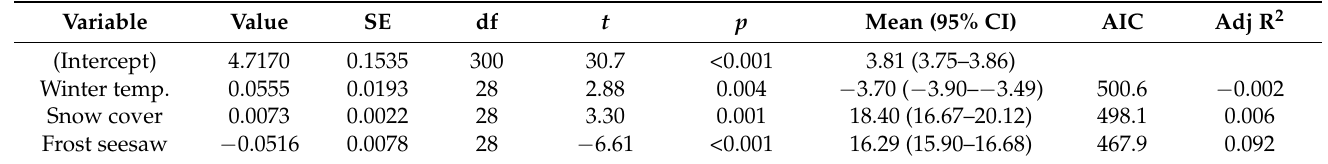
Table 1. Relationships between the winter weather variables examined and the general vole abun- dance index (annual mean clutch size of the Tawny Owl Strix aluco population studied). Generalised linear model (glm): Voleindex.model <- glm (vole index ~ winter temperature + snow cover + frost seesaw). The parameter estimates of data (mean and 95% confidence interval) are given.